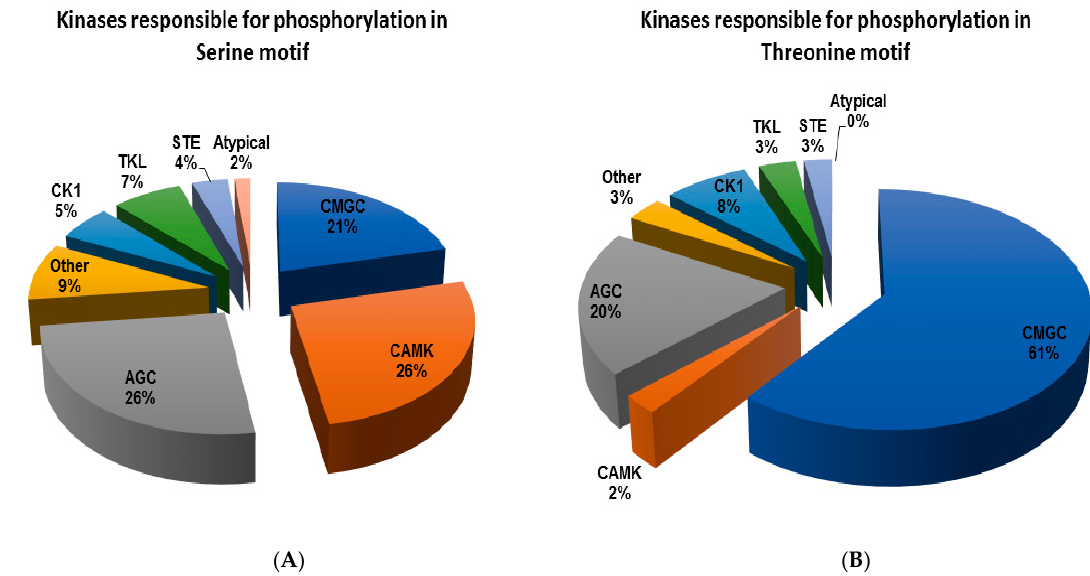
Figure 5. Distribution of the predicted kinase families responsible for the phosphorylation event in the serine ( A ) and threonine ( B ) motifs.